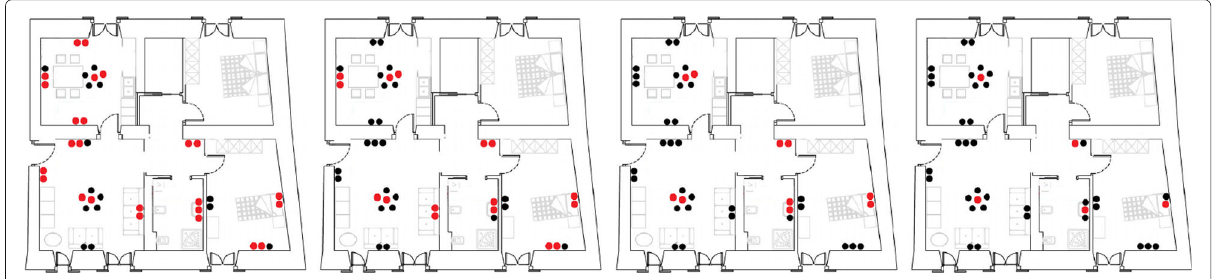
Fig. 12 Reduced microphone setups of Section 8.4. Left to right: | M all | = 25, 16, 10, and 5 microphones used (shown in